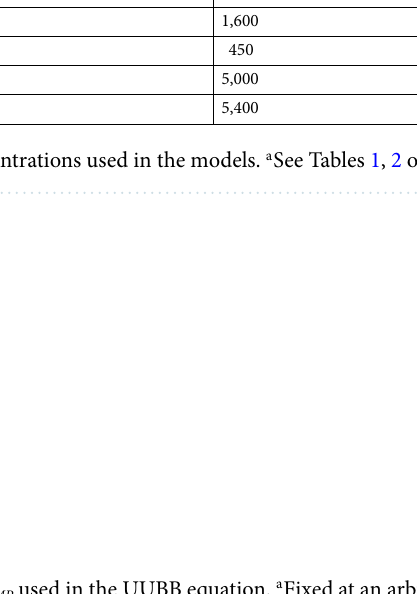
Table 4. K i , K ii and K PPi_AMP used in the UUBB equation. a Fixed at an arbitrary value.